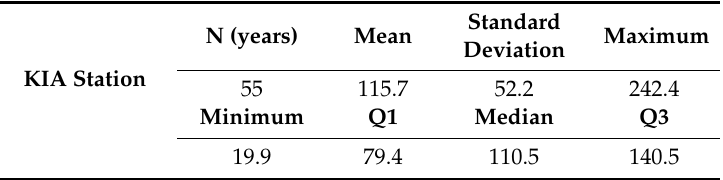
Figure 3. Monthly total rainfall data averages within 12-year duration for six weather stations located in the urban zone of Kuwait City. Table 1. Descriptive statistics for annual precipitation records at Kuwait International Airport weather station (KIA) from 1958-2017. Units are in